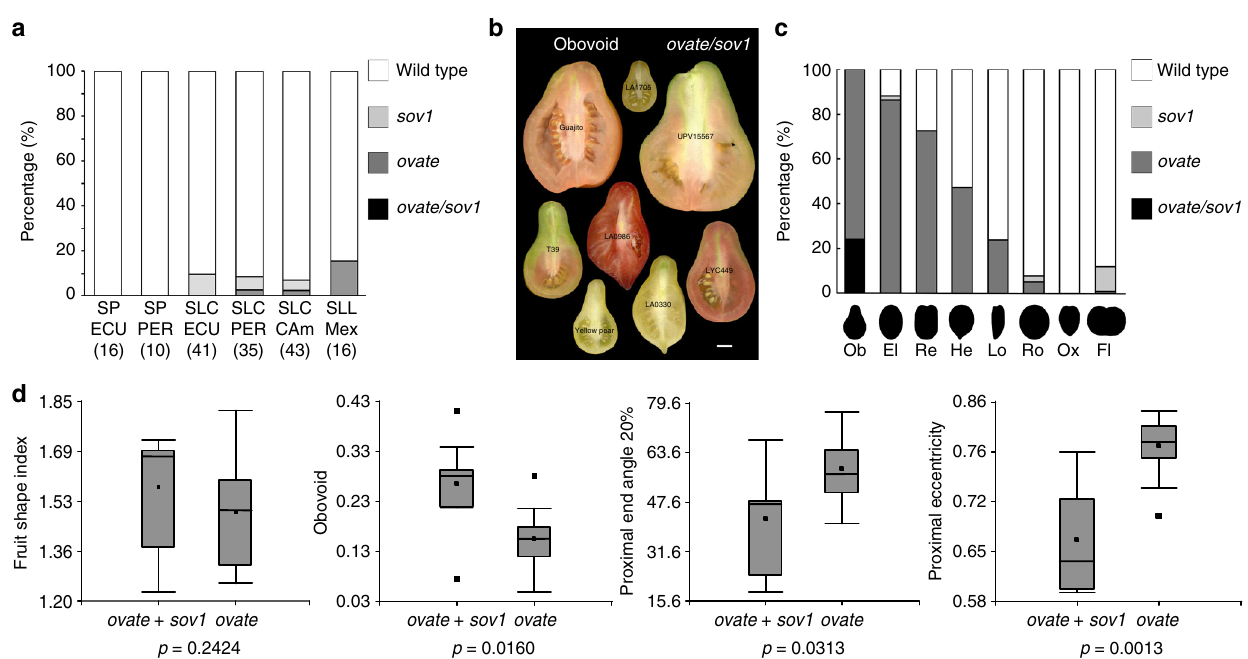
Fig. 5 Distribution of sov1 and ovate in tomato germplasm and its impact on fruit morphology. a Frequency of ovate and sov1 in an ancestral population of tomato. SP ECU, Solanum pimpinellifolium accessions from Ecuador; SP PER, Solanum pimpinellifolium accessions from Peru; SLC ECU, Solanum lycopersicum var. cerasiforme accessions from Ecuador; SLC PER, Solanum lycopersicum var. cerasiforme accessions from Peru, SLC CAm, Solanum lycopersicum var. cerasiforme accessions from Central America; SLL MEX, Solanum lycopersicum var. lycopersicum accessions from Mexico. The number of accession in each category is indicated in parentheses. b Shape of fruits from cultivated tomato accessions carrying both the ovate and sov1 mutations. The scale bar represents 1 cm. c Frequencies of ovate and sov1 in different tomato shape categories in percentage based on the number of accessions in the category. Shape categories are: obovoid (Ob), ellipsoid (El), rectangular (Re), heart (He), long (Lo), round (Ro), oxheart (Ox) and fl at (Fl), respectively. d Variation among fruit shape traits of obovoid fruits for cultivars carrying ovate or ovate/sov1 mutations. The p value represents the result of the student ’ s t -test between